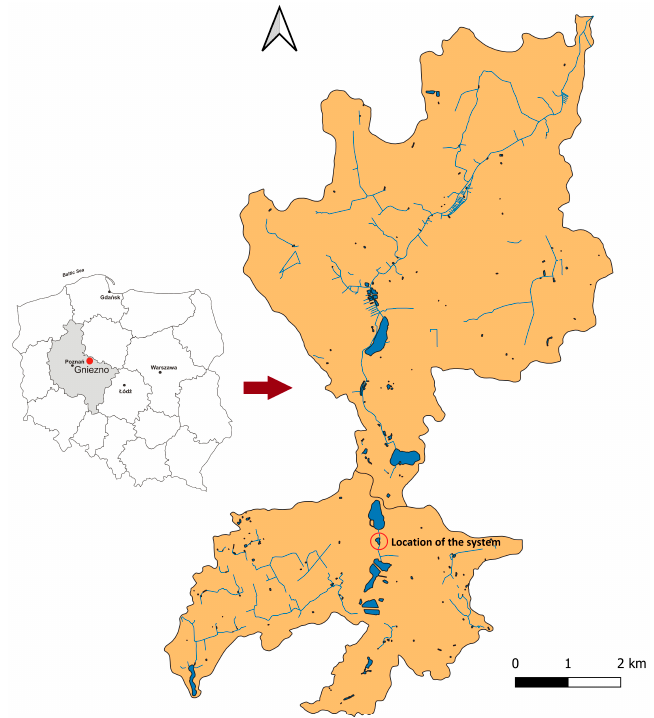
Figure 1. Position of the system in the catchment of the Struga Gnie ź nie ń ska river.